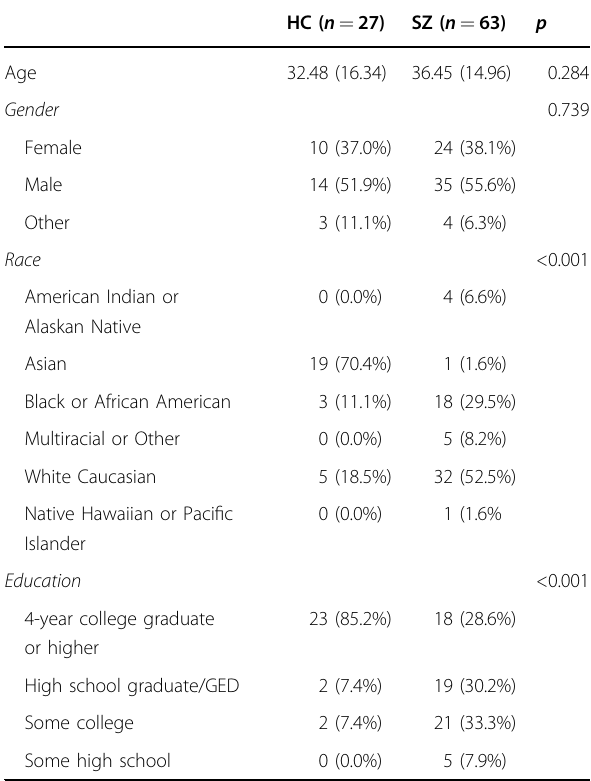
Table 2 Ninety individuals from the greater Boston area participated in this